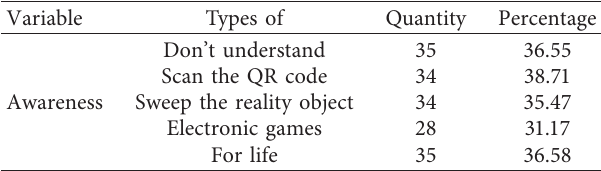
Table 2: User perception statistics.